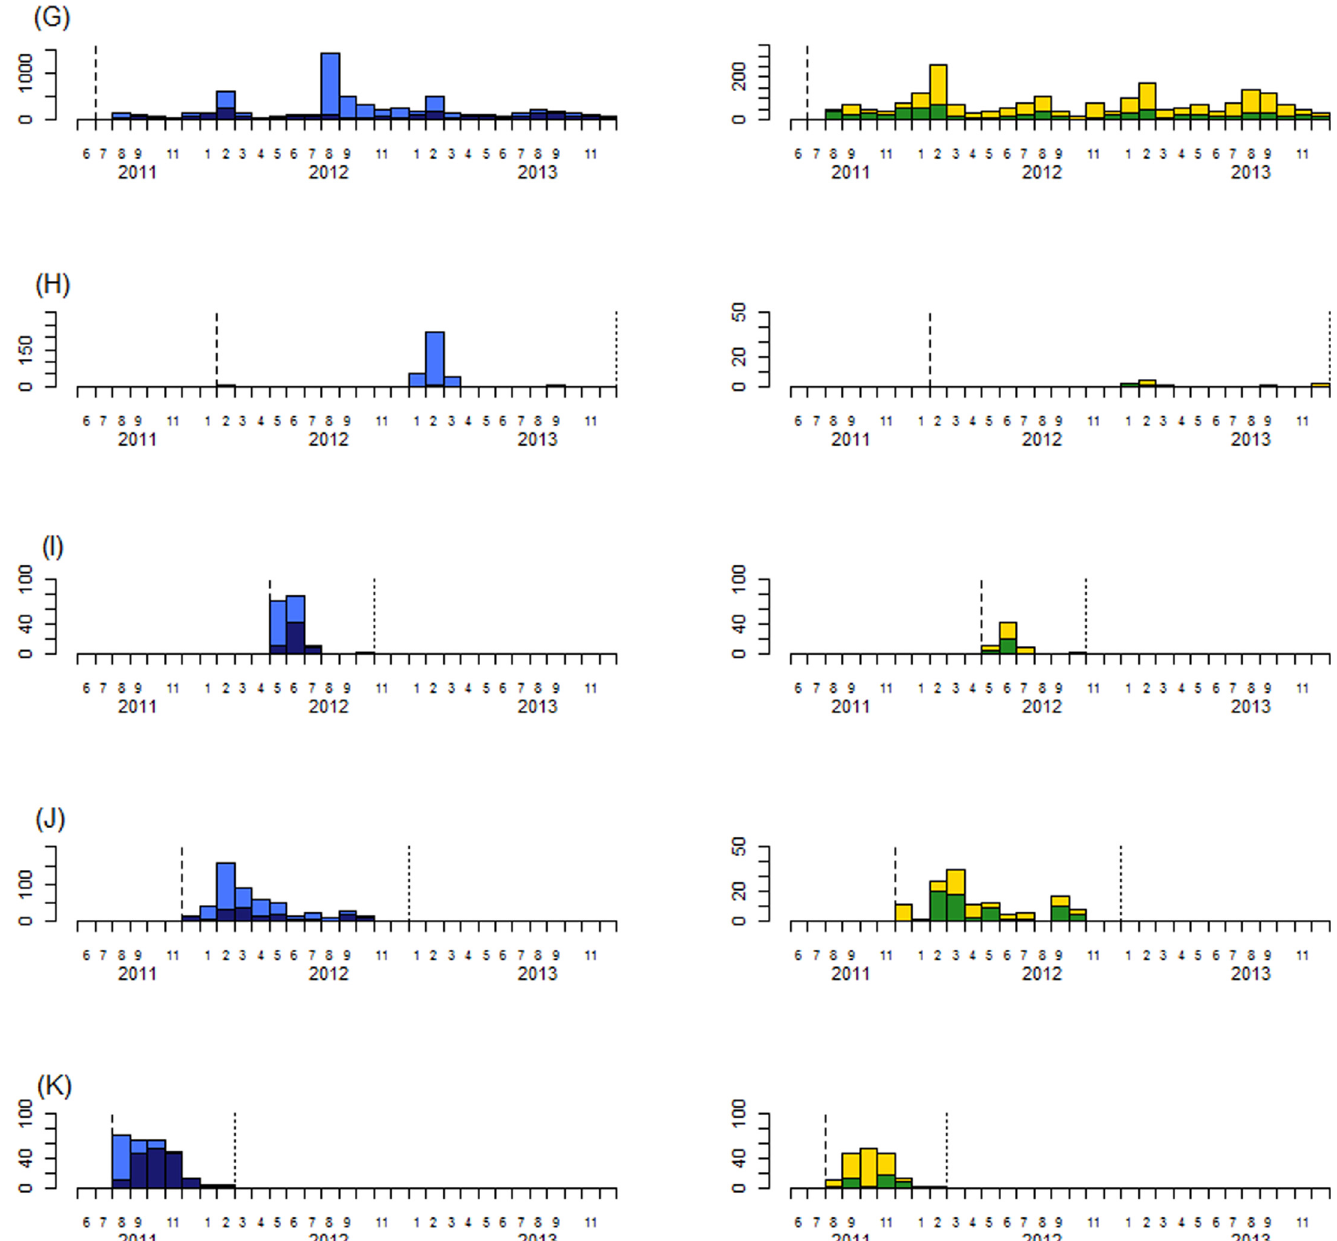
Fig 2. Suspect cases with culture done and Suspect cases with positive culture for Vibrio cholera (second part). Surveillance zone, Goma- Karisimbi districts, DRC (G); outbreak site, Pemba city, Mozambique (H); outbreak site, Adiake prefecture, Cote d ’ Ivoire (I); outbreak site, Kasese district, Uganda (J); outbreak site, Maluku-Kingabwa-Massina districts, Kinshasa, DRC (K). Dark blue bars show cases with culture test done, light blue bars show cases with culture test not done, green bars show cases with Vibrio cholera identified by culture, and yellow bars show cases having a culture negative for Vibrio cholera . The dashed line shows the first month of the enhanced Africhol surveillance. The dotted line shows the last month of the enhanced Africhol surveillance.